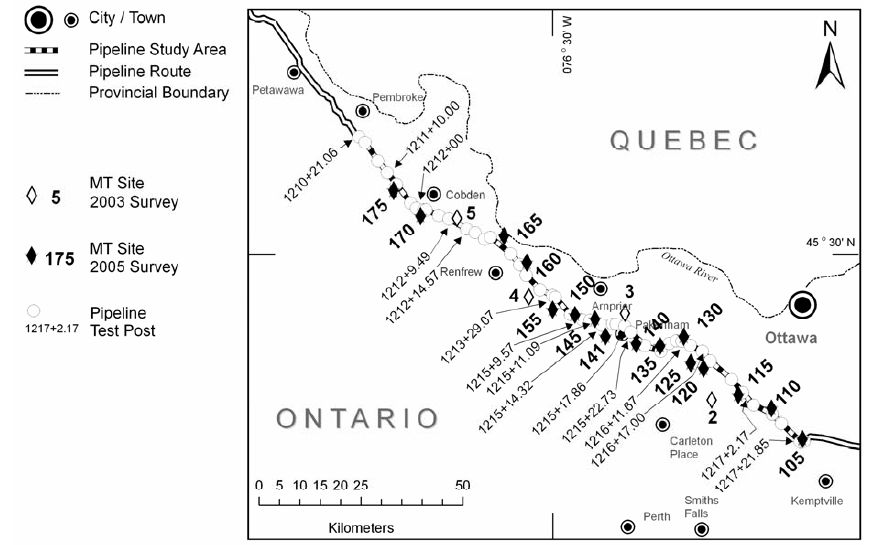
Fig. 3. Location of individual MT sites and test posts along the study area. Test posts near a MT site are marked with identification Figure 3.